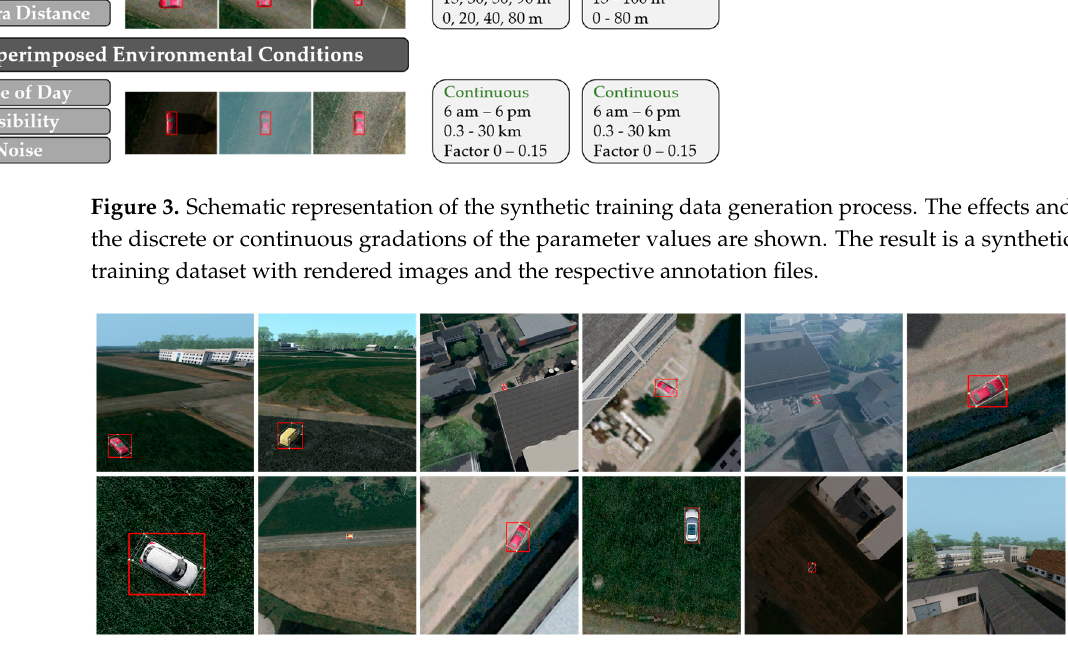
Figure 4. Annotated example images from the synthetically generated training dataset, which are also intended to illustrate the included variations.